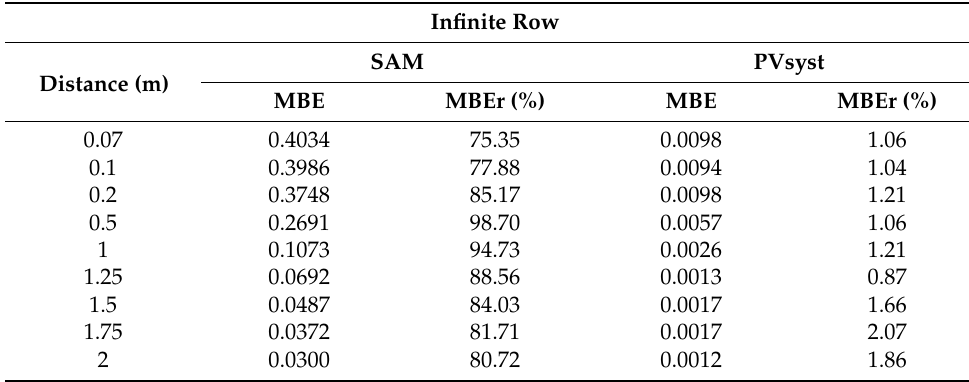
Table 6. MBE for the diffuse shading factor f D . Infinite